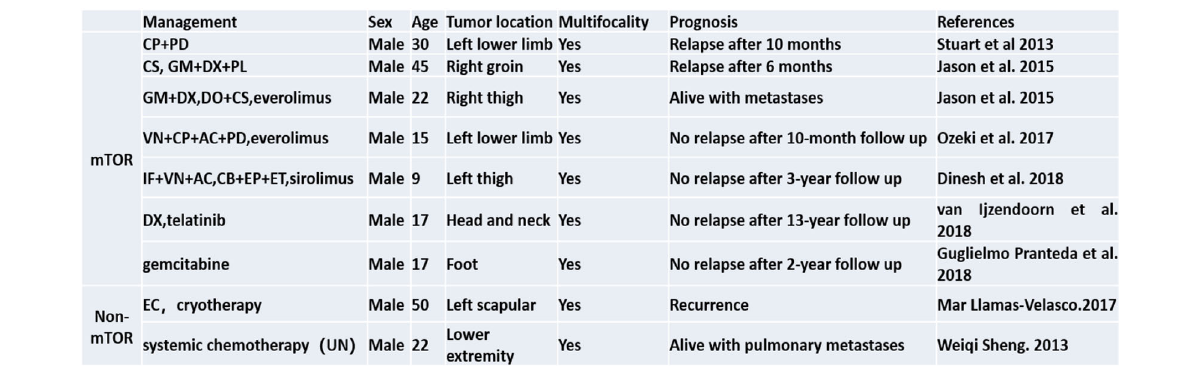
Table 1 Different treatments for PHE/ESH in the literatures